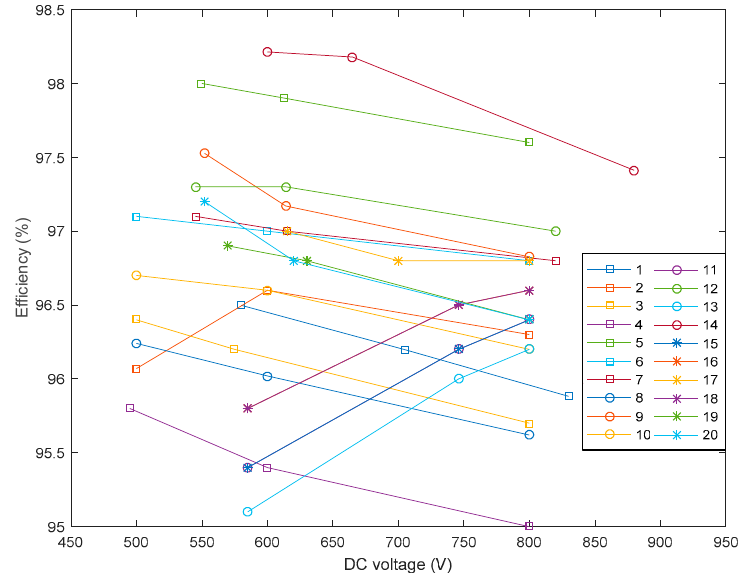
Figure 3. Relationship between the input voltage and the efficiency of the inverters extracted from the CEC Grid Support Inverters List.